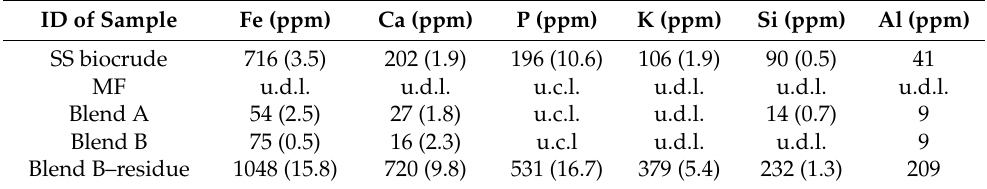
Table 3. Main inorganic elements of SS biocrude, MF and blend samples. (in bracket abs. std. dev.). ID of Sample Fe (ppm) Ca (ppm)